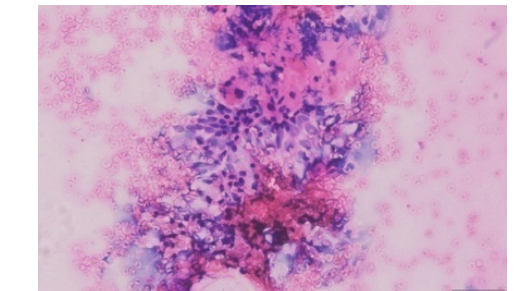
Figure 22 Making cell smear by sliding smear.